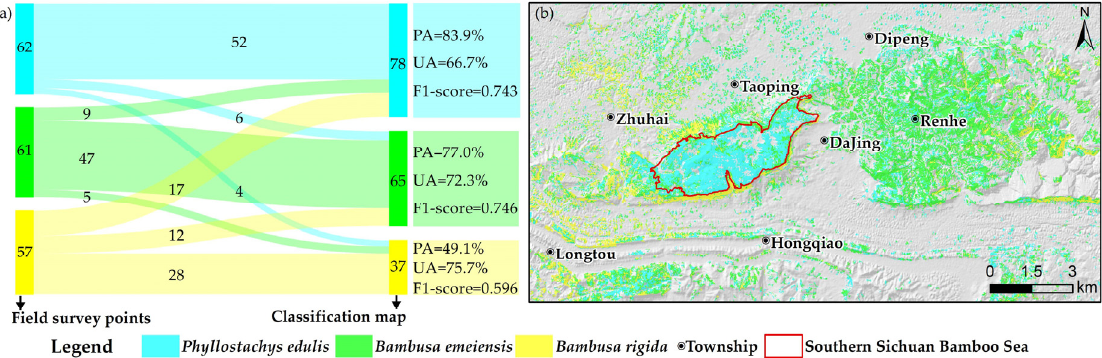
Figure 5. ( a ) Confusion matrix and evaluation indicators of SAM; ( b ) classification map of SAM.